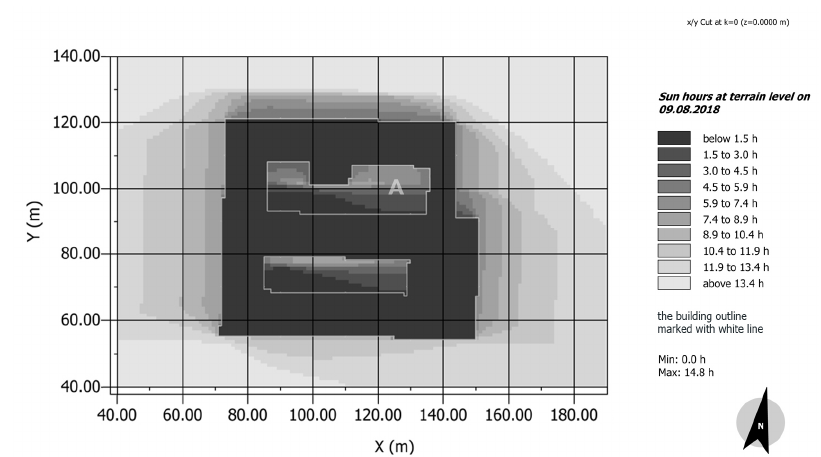
Figure 2. The sun hours at terrain level on August 9, 2018 in the context of the whole model – the atrium is placed in the north part of the complex, marked with the letter A. Figure by authors.